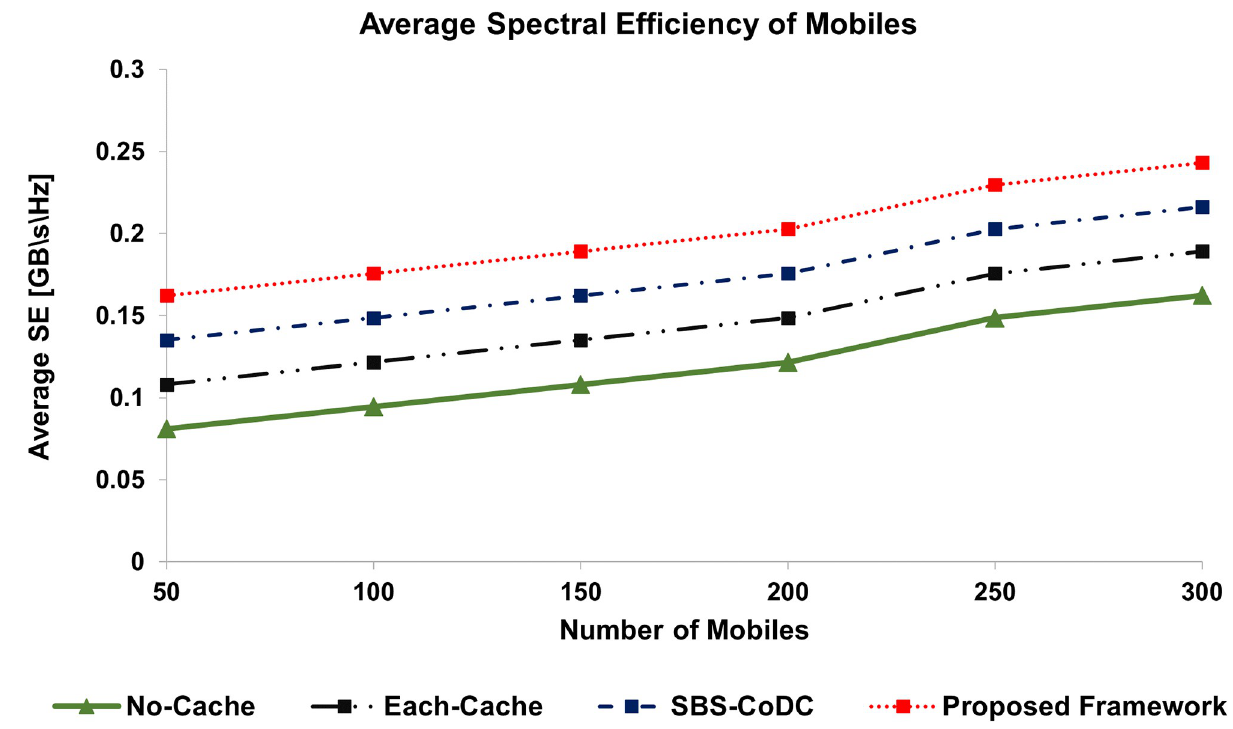
Fig 14. Comparison average spectral efficiency of